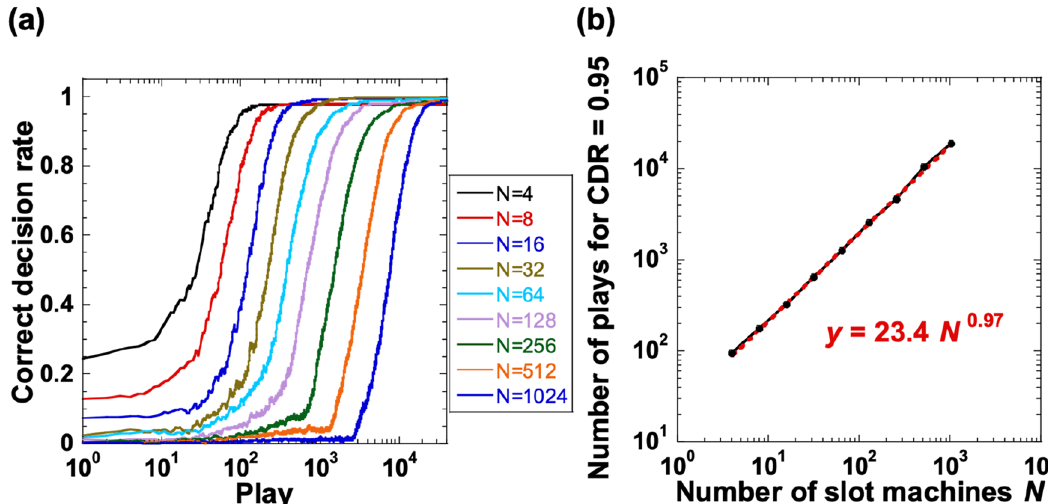
Figure 3. Correct decision rate (CDR) and scaling characteristics. ( a ) CDR as the number of plays increases for different numbers of slot machines from N = 4 to 1024 (2 i , i = 2, 3,…, 10). ( b ) Relationship between the number of plays y at which the CDR reaches 0.95 and the number of slot machines N on double-logarithmic scales. The bias coefficient k is optimized for different values of N (see Fig.